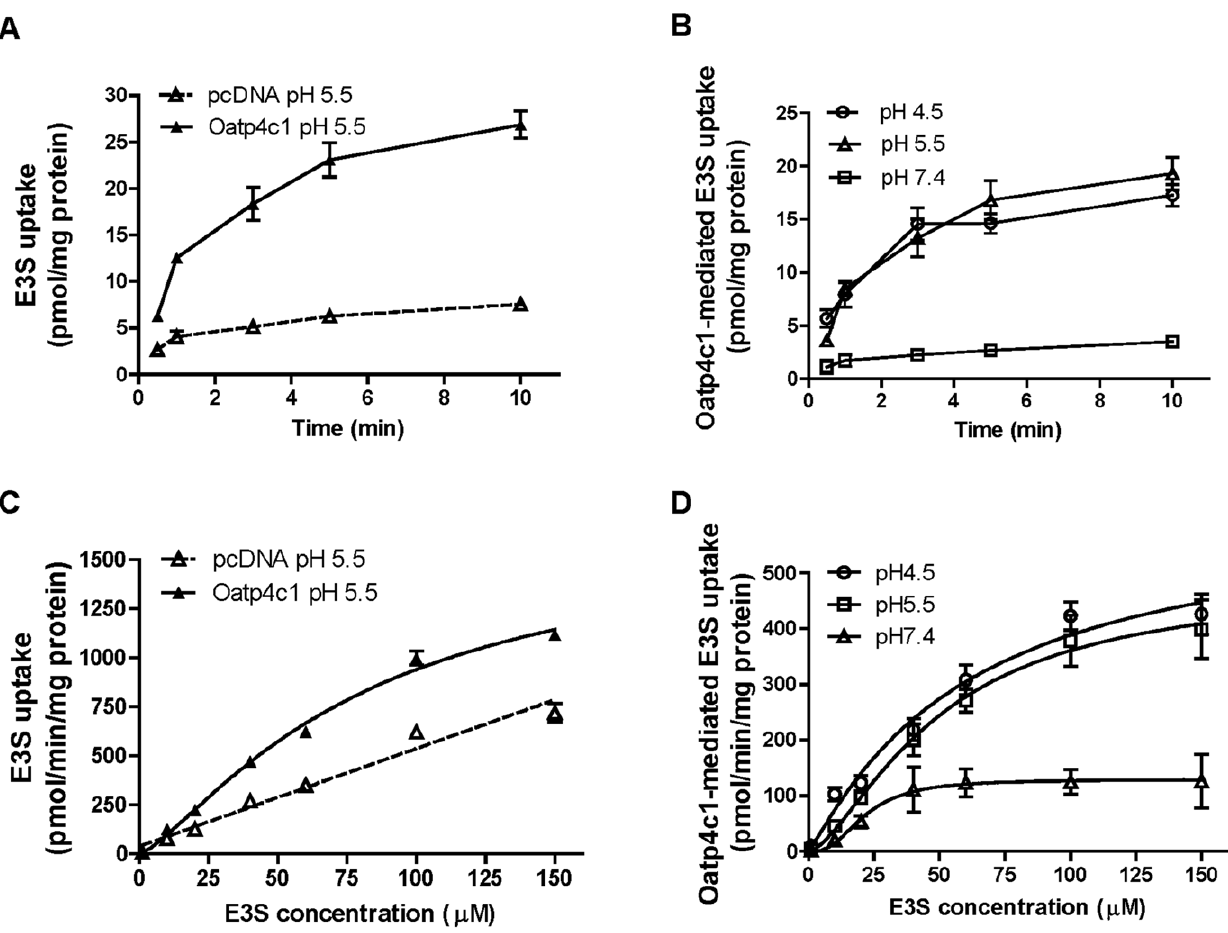
Figure 6. Characteristics of Oatp4c1-mediated E3S transport. Time dependent [ 3 H]-E3S uptake at pH 5.5 by MDCKII-pcDNA and MDCKII- Oatp4c1 cells during incubation with 0.5 m M [ 3 H]-E3S (A). Time dependent Oatp4c1 mediated uptake of [ 3 H]-E3S at pH 4.5, 5.5 and 7.4 (B). Concentration dependent [ 3 H]-E3S uptake in MDCKII-pcDNA and MDCKII-Oatp4c1 cells after incubation at pH 5.5 for 1 min (C). Concentration dependent Oatp4c1 mediated uptake (1 min) of [ 3 H]-E3S at pH 4.5, 5.5 and 7.4 (D). GF: GF120918, MTX: methotrexate. Each point represents the mean 6 S.D. of triplicates. *p , 0.05, significant differences from control.